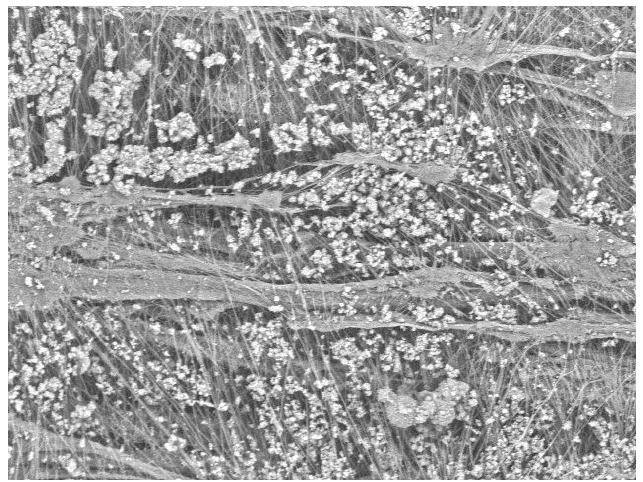
Figure 8. The adhesion of dust on the surface of APMCNF filter media.